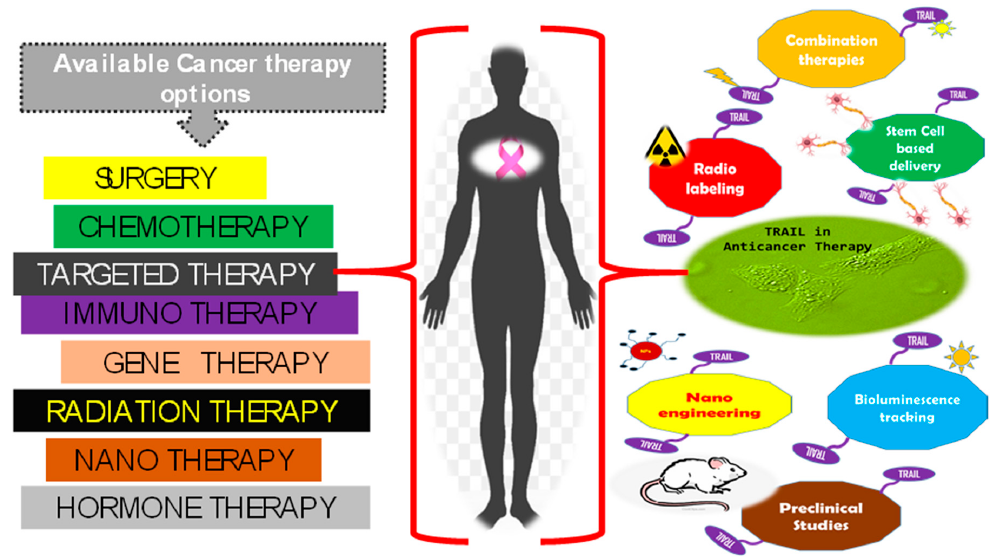
Figure 1. Overview of cancer therapies available and TNF-related apoptosis-inducing ligand (TRAIL) mediated anti-cancer options.